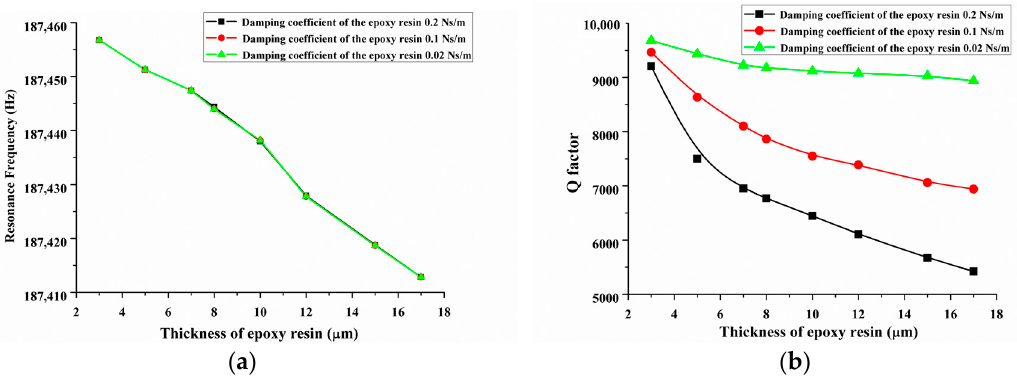
Figure 13. Relationship between the high mode ( a ) resonance frequency and ( b ) Q -factor with the thickness of the epoxy layer under three typical damping coefficient values.